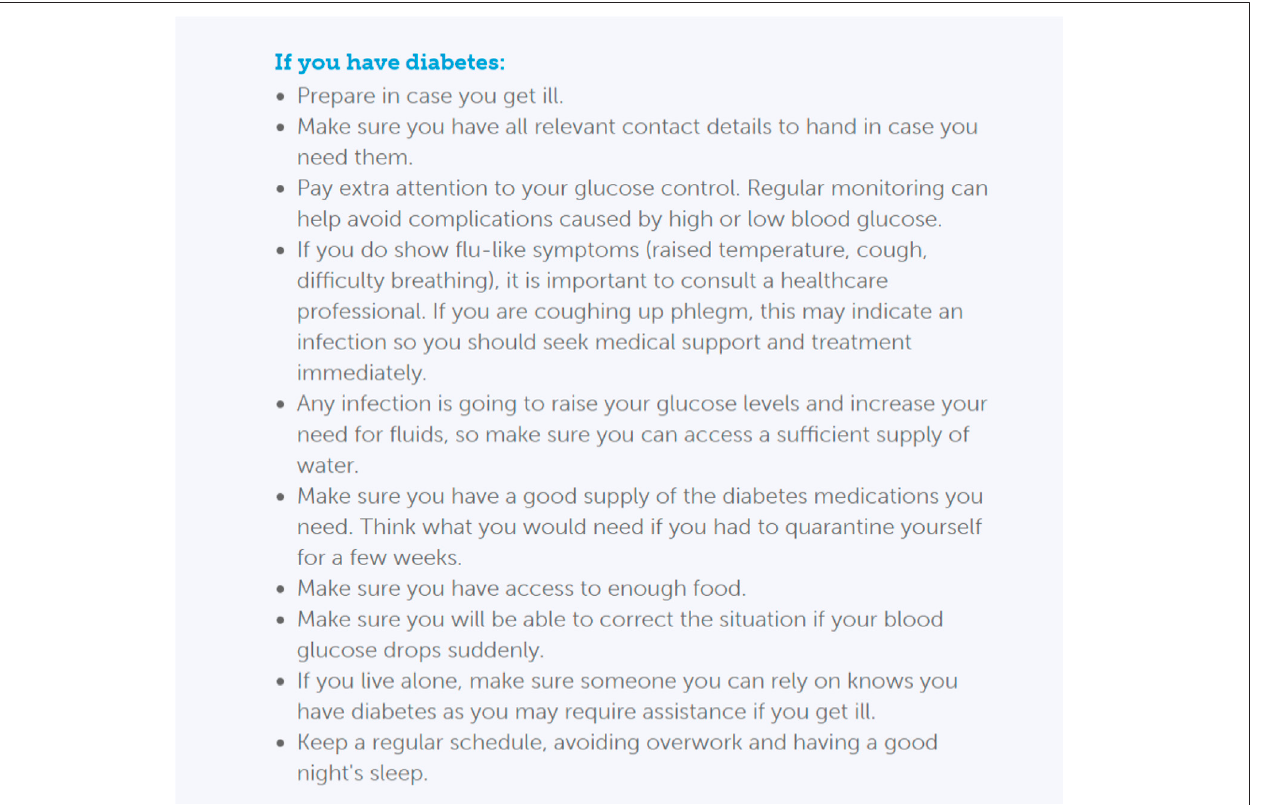
Frontiers in Blockchain |